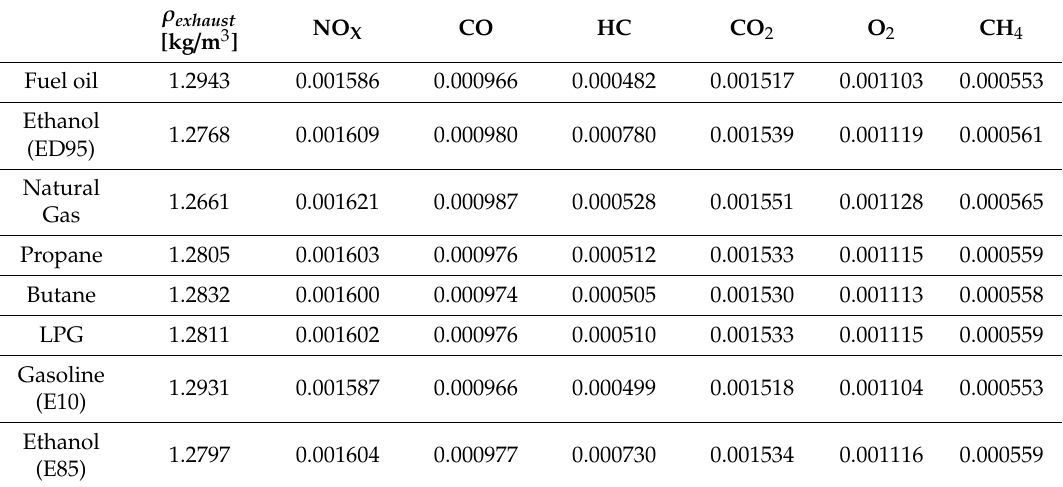
Table 3. Component specific factor µ